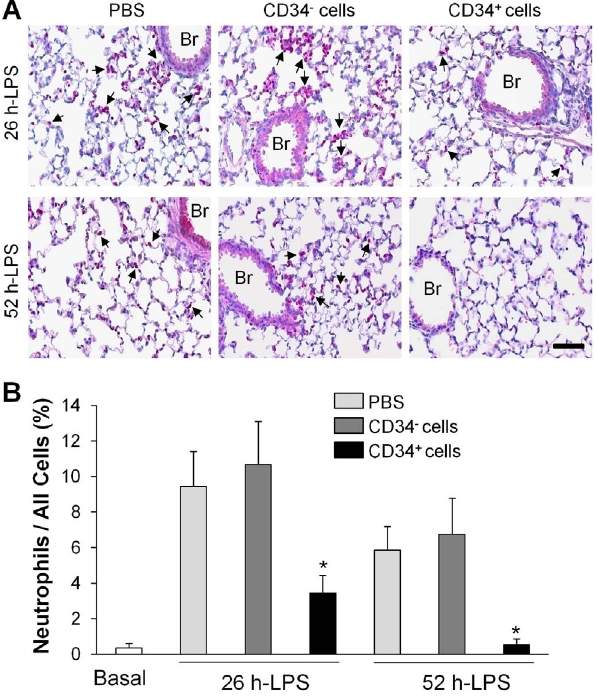
Figure 3. Decreased lung tissue neutrophil infiltration in fCB- CD34 + cell-treated mice. Lung tissues at indicated times post-LPS challenge were collected and sectioned for polynuclear granulocyte- specific chloroacetate esterase staining. ( A ) Representative micrographs of chloroacetate esterase staining (purple) showing neutrophil infiltra- tion in mouse lungs after LPS challenge. Arrows indicate positive staining. Br, bronchia. Scale bar: 50 m m. ( B ) Quantitative analysis of infiltrating neutrophils in mouse lungs. Data are expressed as mean 6 SD ( n =4/group). *, P , 0.05 versus PBS or CD34 + .